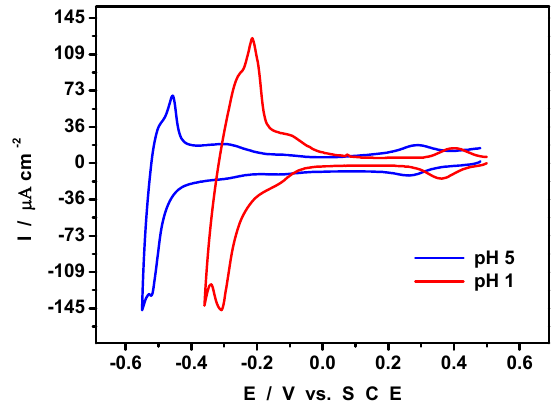
Figure 6. Cyclic voltammograms run at two different pH values with a Pd 0 @POM glassy carbon-modified electrode. The potential excursion was restricted to the domain where Pd 0 electro-oxidation does not occur. The scan rate was 10 mV s -1 ; reference electrode was SCE. (red) pH = 1; (blue) pH =